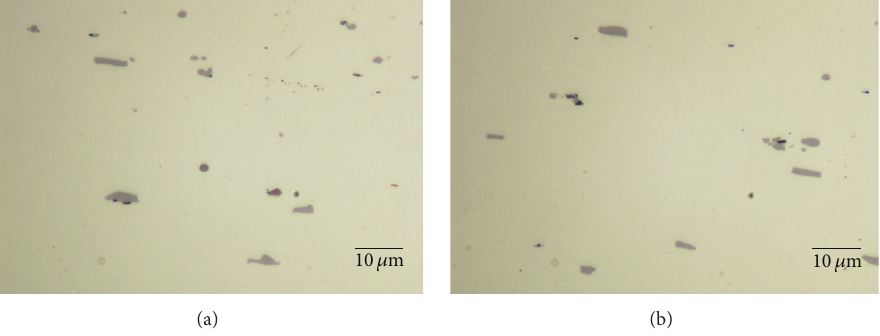
Figure 9: (a) Polished AR sample. (b) Polished CTed sample.